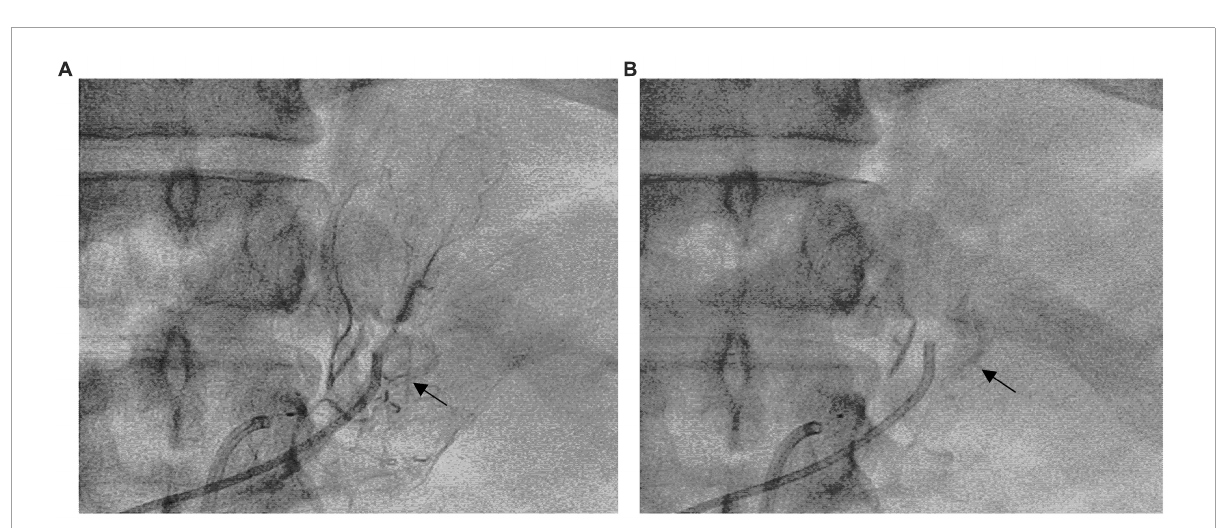
FIGURE2 Superselective adrenal arterial embolization. (A) Angiography of the left middle adrenal artery showing enhancement of the left adrenal adenoma (Arrow). (B) Post-embolization angiography of the left middle adrenal artery confirming no blood flow to the adenoma